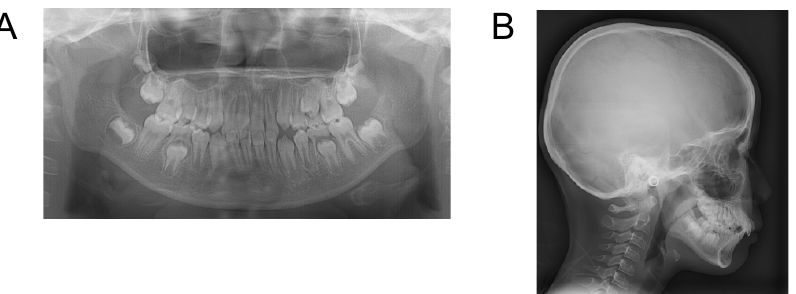
Figure 8. Panoramic radiograph ( A ) and lateral roentgenographic cephalogram ( B ) of Case 2 at initial examination. Table 3. Cephalogram angle measurements of Case 2.